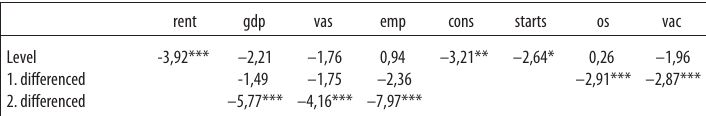
Fig. 4. Augmented Dickey-Fuller tests